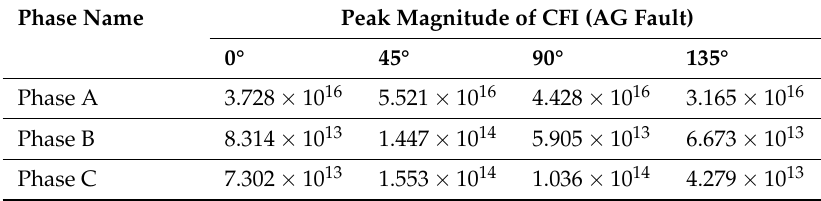
Table 4. Performance of Fault Recognition Algorithm with Variable angle of Fault